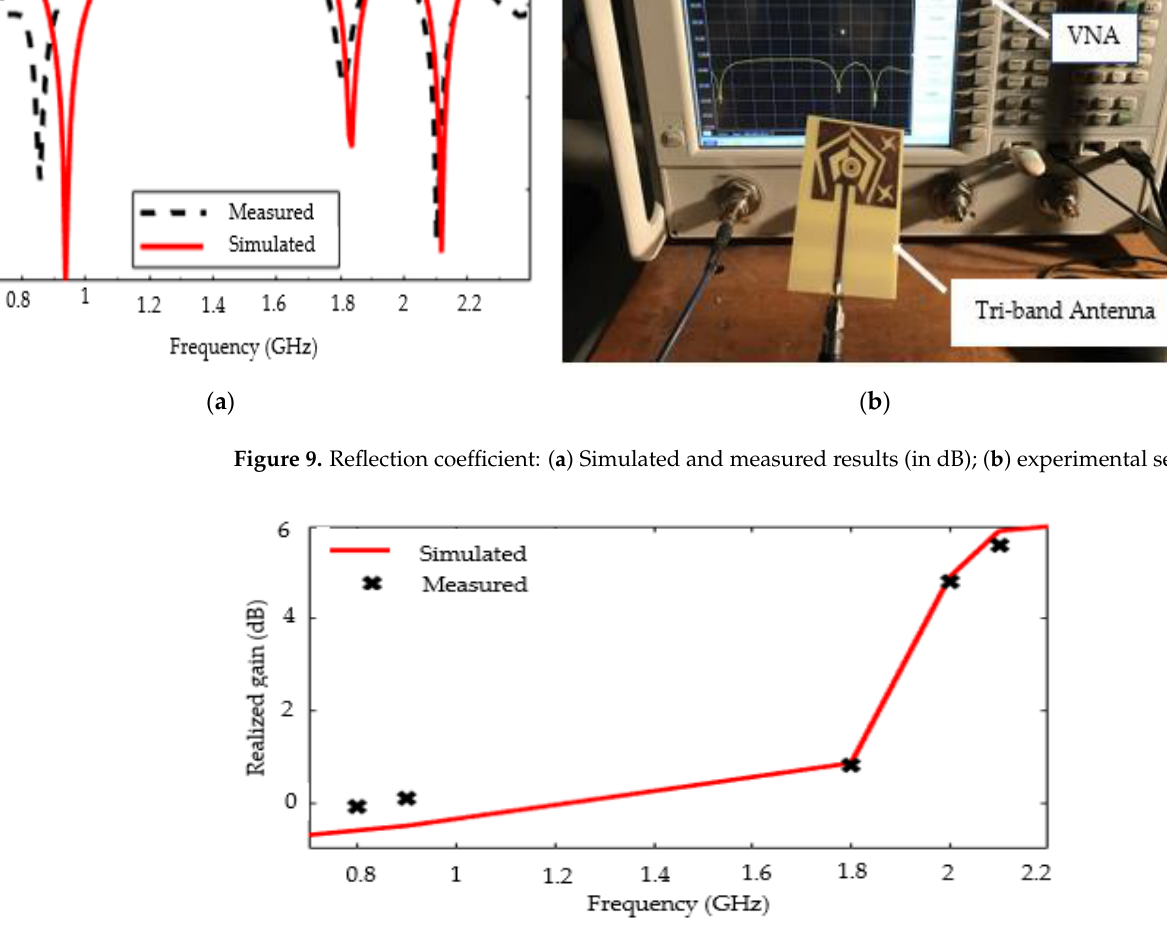
Figure 10. Simulated and measured realized gain of the tri-band antenna as function of frequency.